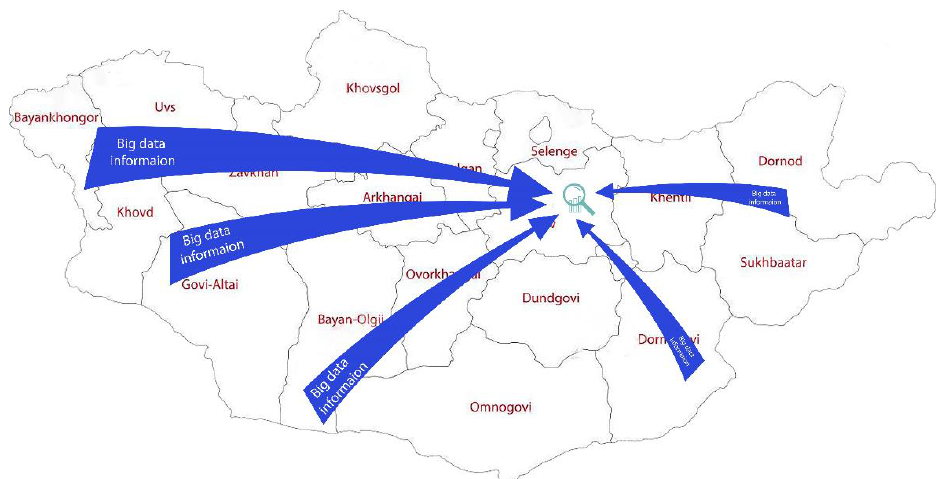
Figure 12. Mongolia STDs comprehensive big data virtualization. 5. Inter-Country Big Data Analysis According to HIV, One of the STDs (Focused on Mongolia)